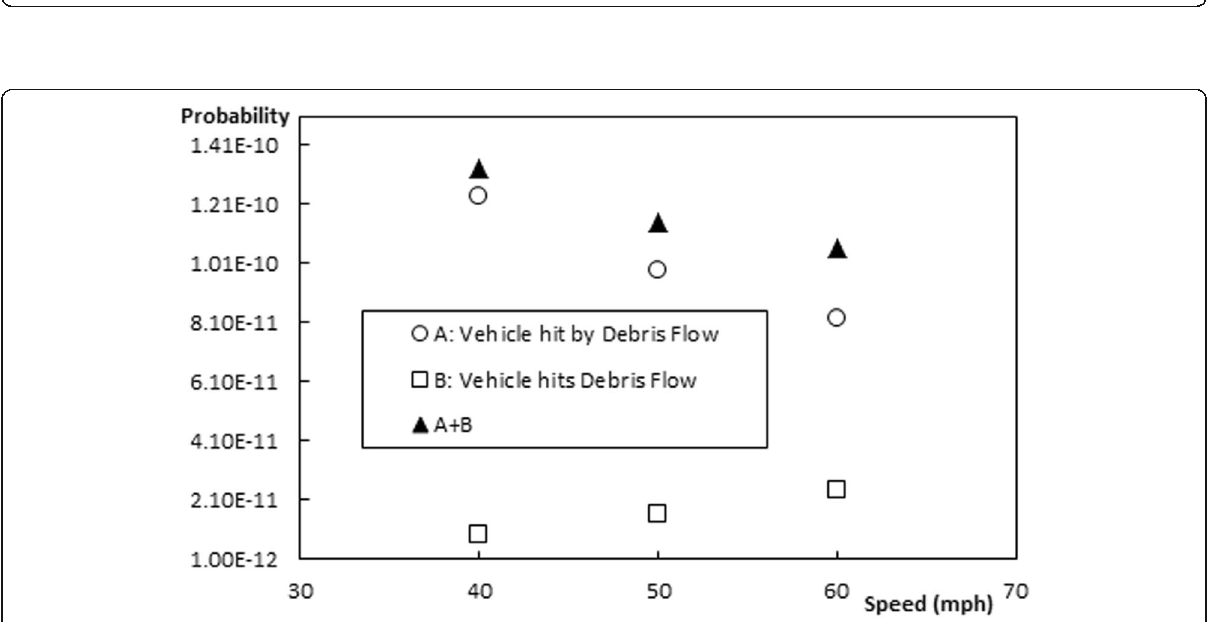
Fig. 16 F - N curve showing the risk reduction for the A83 due to the mitigation measures extant as of October 2014 based on the Wong et al. (2004) approach. The dashed lines represent the risk after the mitigation measures are taken into account. Note that the line for Scenarios A and B combined is partly obscured by that for Scenario A